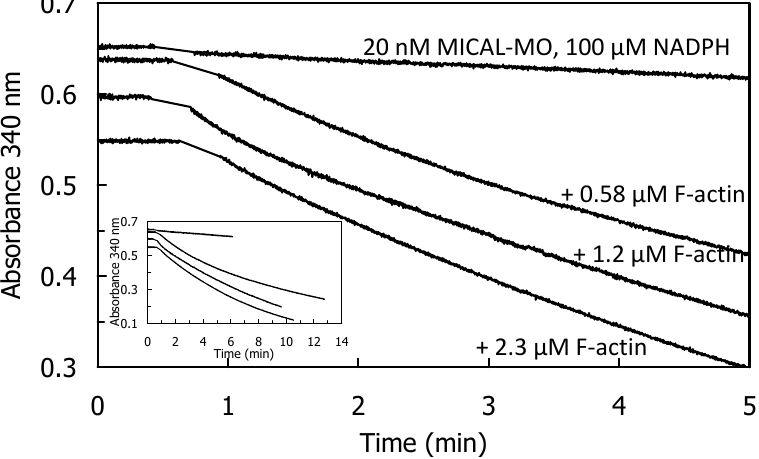
Figure 14. Time-course and extent of NADPH oxidation in the presence of human MICAL-MO and varying F-actin concentrations. Human MICAL-MO (20 nM) and NADPH (100  M) were added to a solution containing the indicated concentrations of F-actin in F-buffer (9 mM Tris/HCl, pH 8.0, 0.18 mM CaCl , 1.1 mM ATP, 1.3 mM DTT, 2 ). The absorbance changes at 340 nm were monitored. The 45 mM KCl, 1.8 mM MgCl 2 inset shows the same traces but on a different time-scale. Reprinted from [70] with permission from Elsevier.